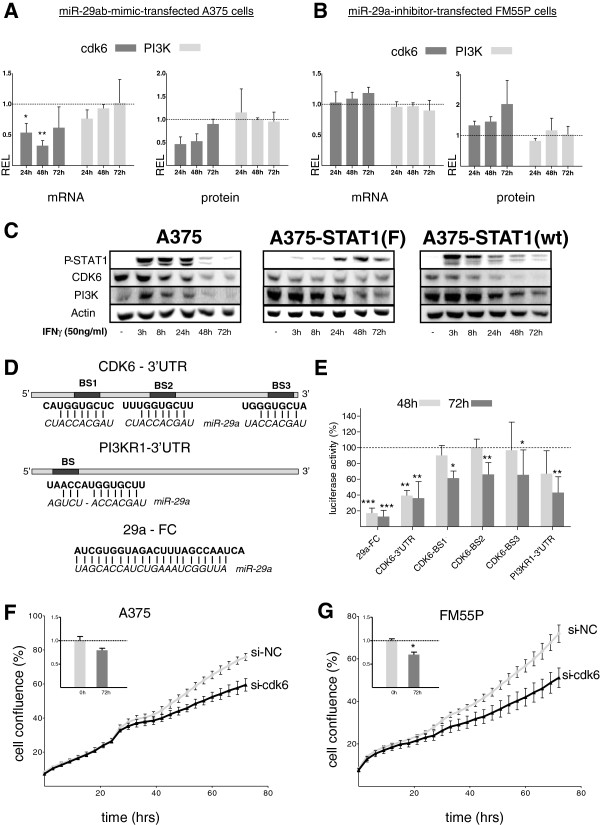
Effects of miR-29 on target genes CDK6 and PI3K. (A,B) relative mRNA and protein expression levels (REL) of miR-29 target genes CDK6 (dark grey) and PI3K (light grey), assessed 24h, 48h and 72h after mimic/inhibitor transfection compared to NC-mimic/NC-inhibitor controls; graphs show means of biological triplicates ± SD. (C) Down-regulation of miR-29 target proteins CDK6 and PI3K is observed after IFN-γ stimulation of melanoma cells. (D) Schematic overview of CDK6 and PI3KR1 luciferase constructs with positions of conserved miR-29a binding sites predicted by TargetScan (bold) in the CDK6-3'UTR (BS1-3) and PI3KR1-3'UTR (BS) and corresponding miR-29a sequences (italics). (E) Luciferase activity in A375 cells transfected with constructs containing the positive control miR-29a full complementary sequence (29a-FC), parts of CDK6- or PI3K1-3'UTRs or CDK6 single binding sites (BS1-BS3) and miR-29a mimic or NC for 48h and 72h. Relative luciferase activity of miR-29a-transfected samples was normalized to NC-mimic-transfected control samples (luciferase activity of NC-mimic transfected samples was set to 100%). Bars show means of biological triplicates ± SD for each construct. (F) A375 and (G) FM55P cells transfected with CDK6 siRNA (black) show reduced proliferation compared to cells transfected with siRNA NC (grey). Results were reproduced at least in biological duplicates. Inserted bar diagrams show the mean confluence of at least biological triplicates at 0h and 72h. Shown are confluence ratios of si-CDK6/si-NC ± SEM. Significance was assessed by one-way ANOVA followed by a Bonferroni Post-Hoc test (A,B,E) or by a two-tailed t-test (F,G). * p<0.05, ** p<0.01 and *** p<0.001.